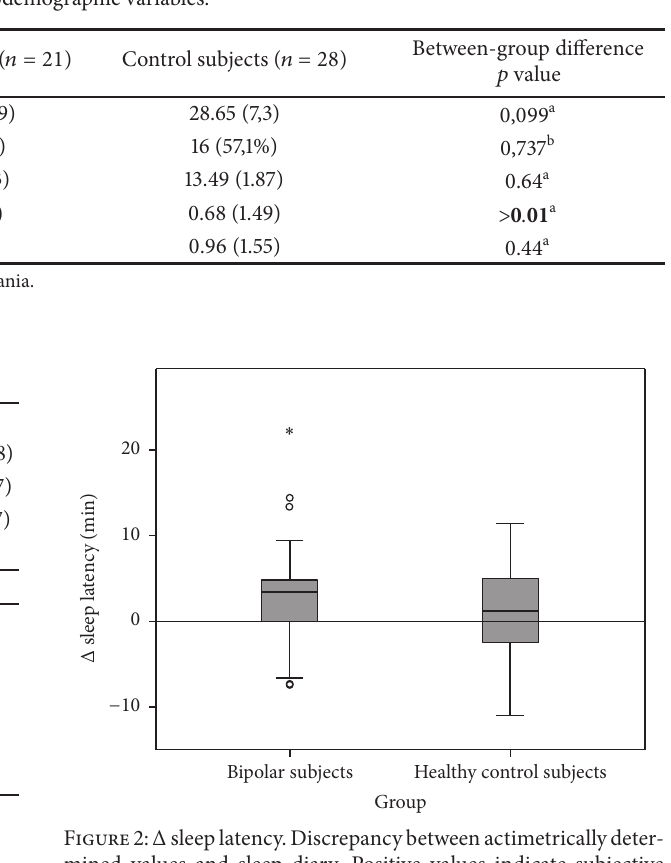
Table 1: Sociodemographic variables.